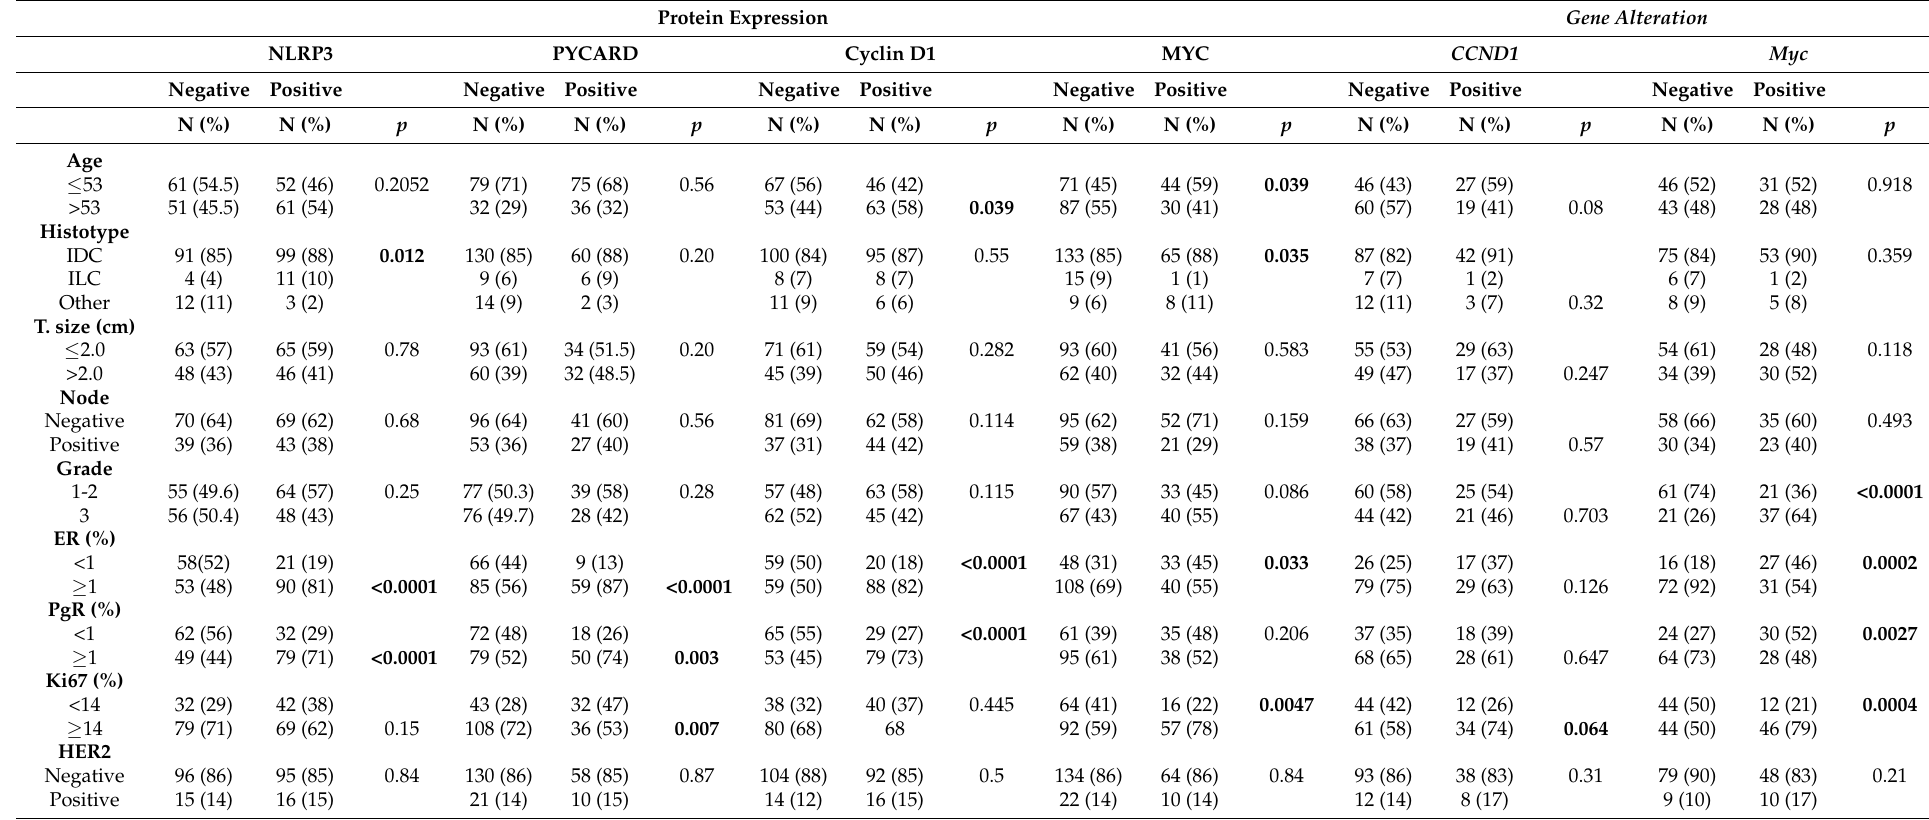
Table 2. Relationship between tumor markers and clinicopathological